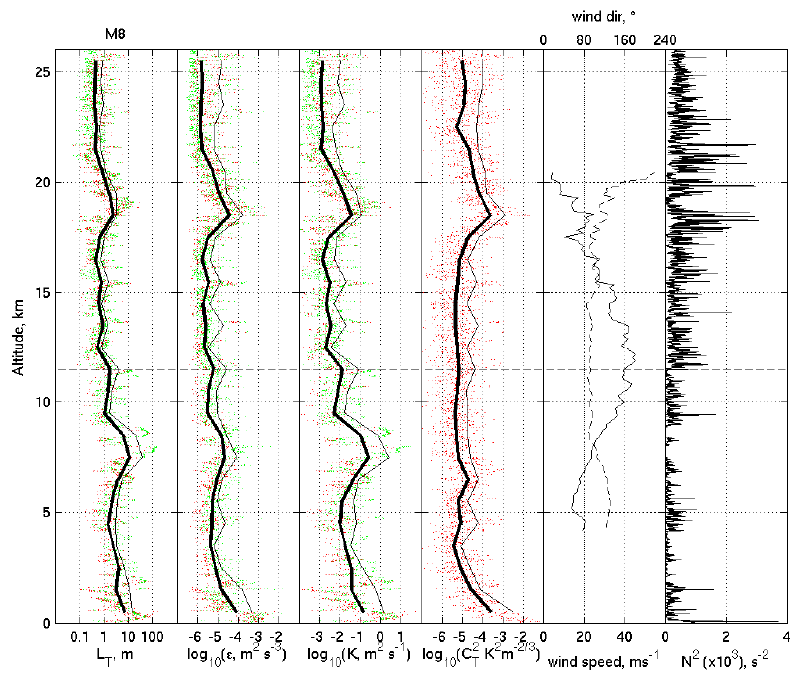
C with their T L , ε , and K are T